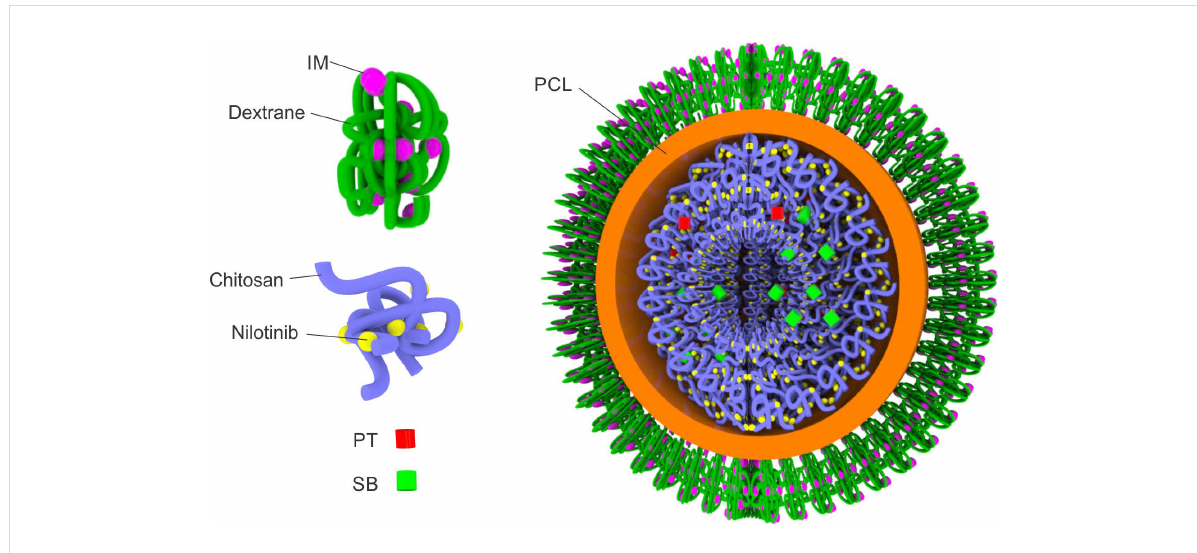
Figure 3: Wool-like hollow polycaprolactone (PCL) NDDS for the sequential co-delivery of imatinib mesylate (IM) and nilotinib (PT: potassium tartrate, SB: sodium bicarbonate). Nilotinib is released at low pH values as pores are formed in the PCL shell due to CO 2 generated by PT and SB (preferably in the lysosomes), followed by IM release from the dextrane complexes in the cytoplasm due to the activity of the intracellular protease. Adapted from